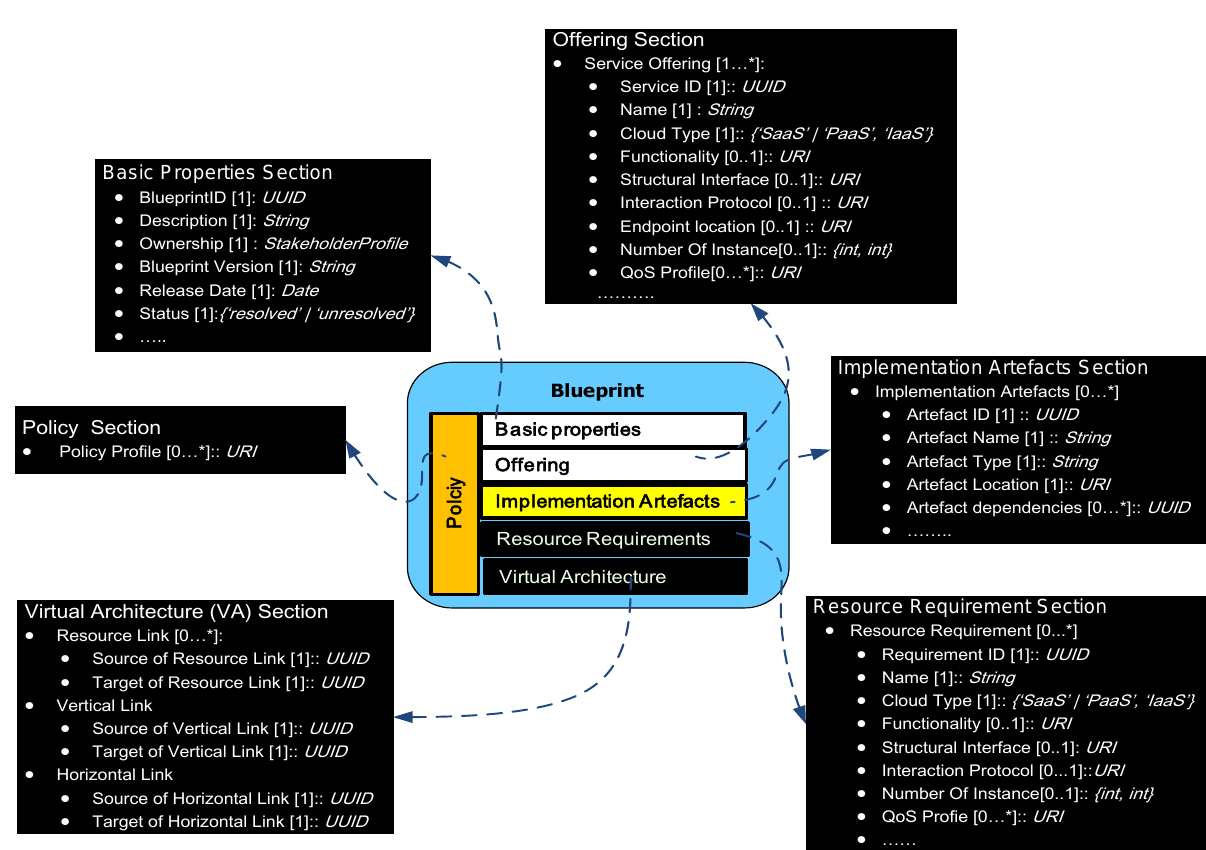
Figure 4. The Blueprint Template.